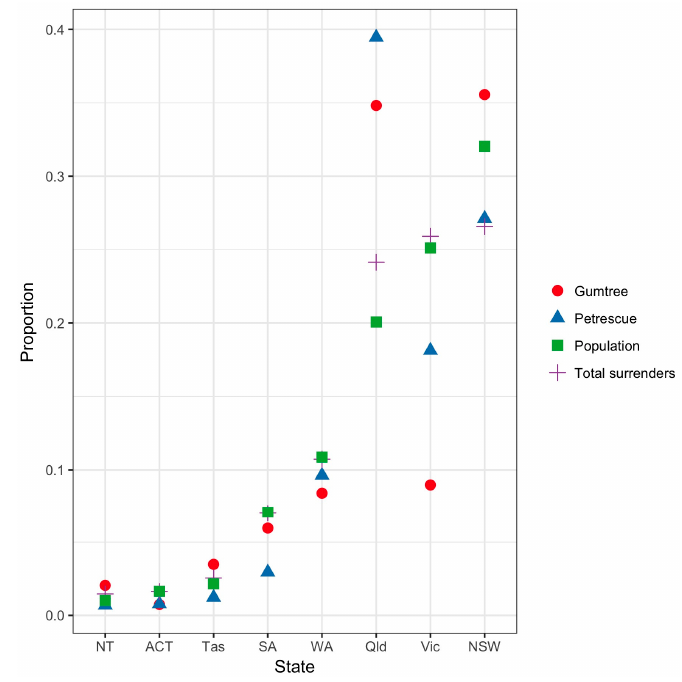
Figure 1. Proportions of total ads for relinquished dogs on Gumtree and PetRescue from 8 to 24 February 2016 and total dog shelter admissions from Chua, Rand and Morton [2] for each Australian State/Territory. States/Territories are ordered in increasing proportion of total population. The square symbol is the proportion of the Australian population for each State/Territory. (Note: The proportion of the Australian population in each State/Territory is: New South Wales (NSW) 31.7%, Victoria (Vic) 24.9%, Queensland (Qld) 19.9%, Western Australia (WA) 10.8%, South Australia (SA) 7%, Tasmania (Tas) 2.1%, Australian Capital Territory (ACT) 1.6% and Northern Territory (NT) 1%).